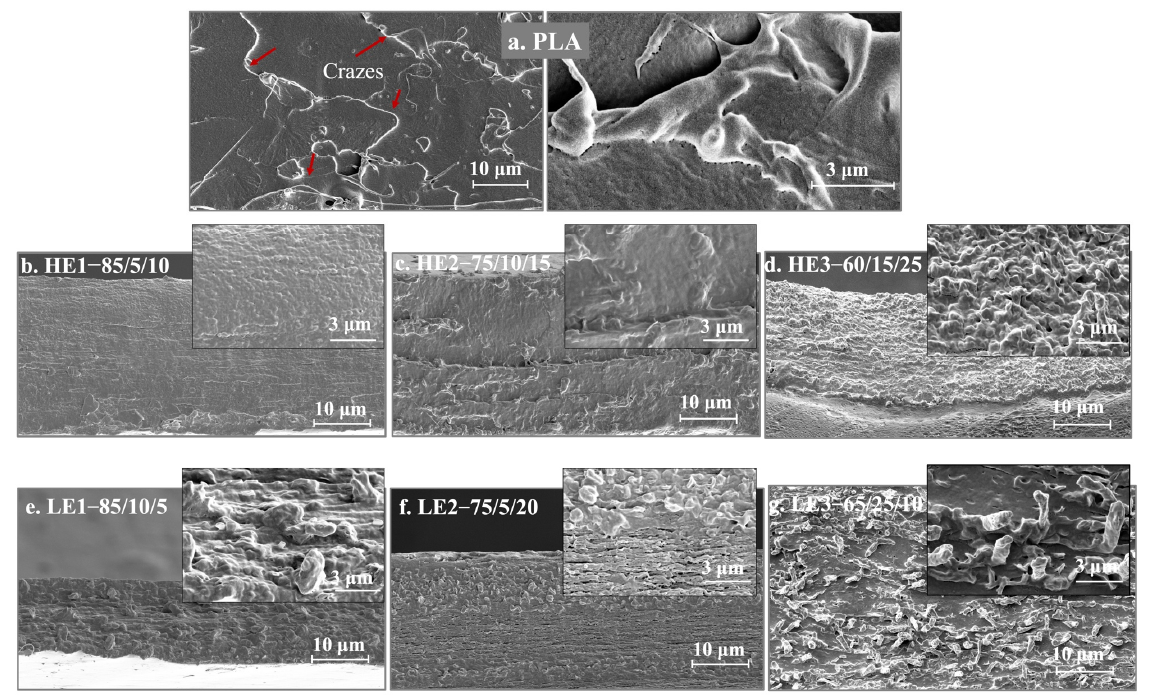
Figure 3. Morphology of ternary-blended, melt-blown films of PLA/PCL/CAB from tensile-fractured surface at 2000× and at 10,000× (inset images), together with PLA: ( a ) PLA, ( b ) HE1–85/5/10, ( c ) HE2–75/10/15, ( d ) HE3–60/15/25, ( e ) LE1–85/10/5, ( f ) LE2–75/5/20, ( g ) LE3–65/25/10.